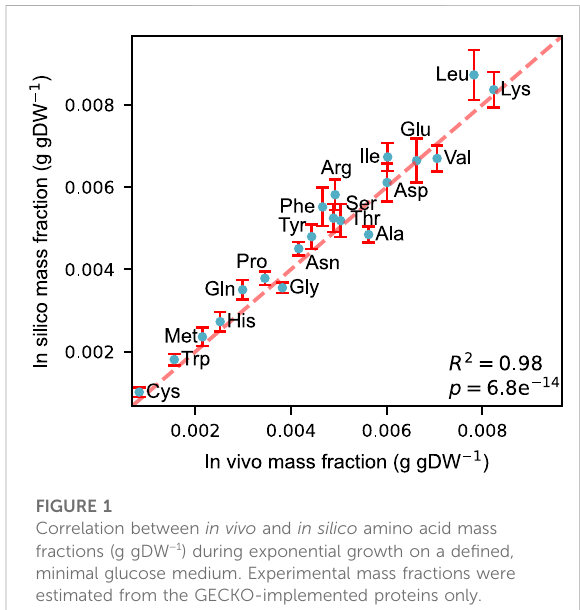
FIGURE 1 Correlation between in vivo and in silico amino acid mass fractions (g gDW − 1 ) during exponential growth on a de fi ned, minimal glucose medium. Experimental mass fractions were estimated from the GECKO-implemented proteins only. Error bars denote the simulated variability of amino acid usage at 99% of the optimal objective